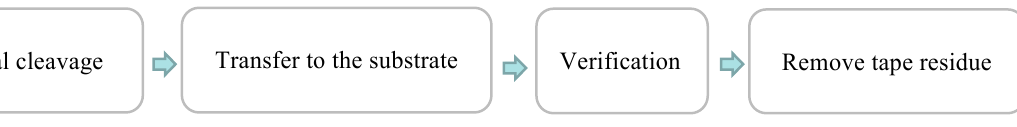
Figure 1. The prepared process of h-BN